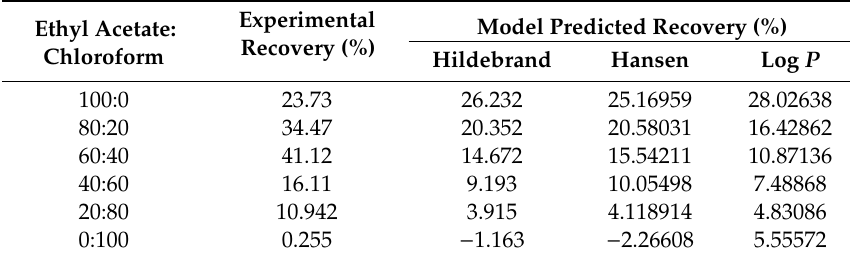
Table 5. Experimental and predicted recovery of rosmarinic acid using di ff erent solubility models. Ethyl Acetate: